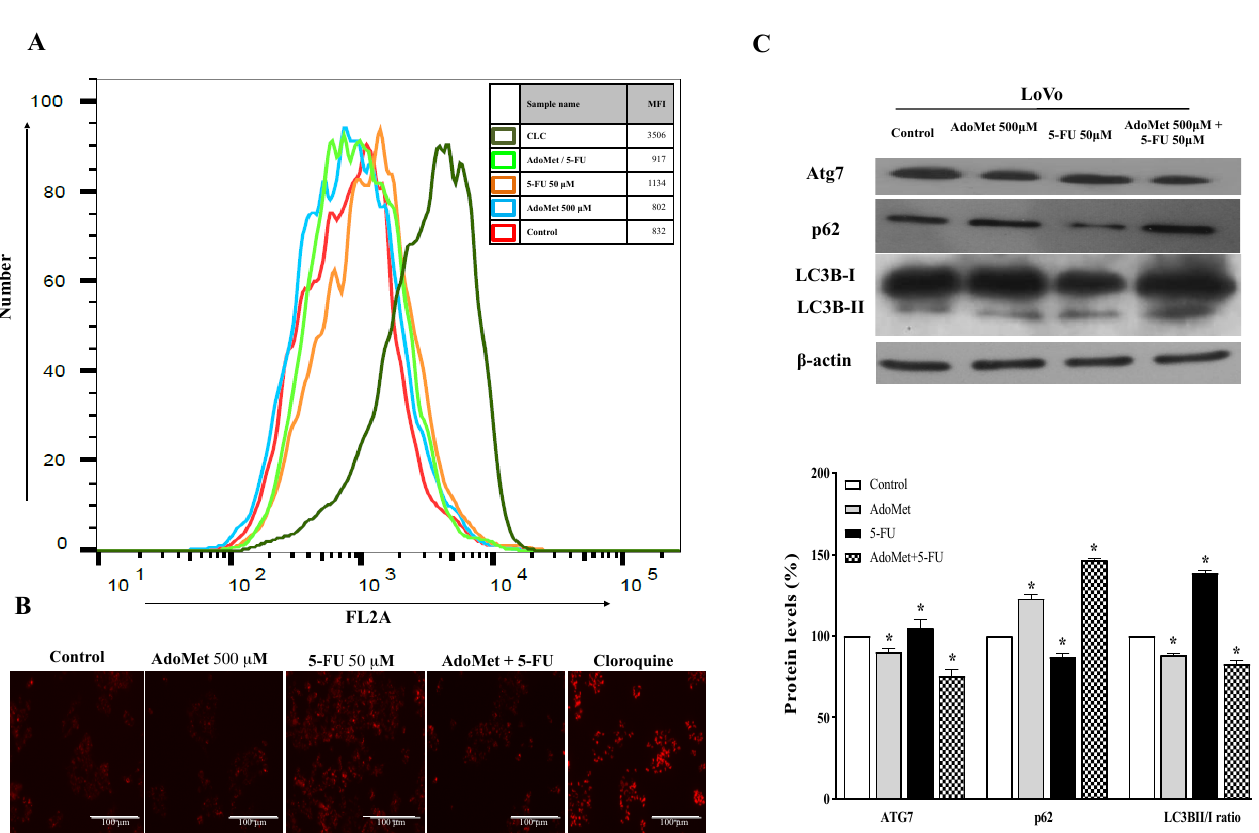
Figure 5. Effects of AdoMet, 5-FU, and their combination on the autophagic process in LoVo cells. Cells were treated with 5-FU 50 µ M for 24 h with and without pretreatment with 500 µ M AdoMet for 24 h. Cells were then incubated with LTR and analyzed by flow cytometry ( A ) and fluorescence microscopy ( B ). Chloroquine was used as a positive control. For the quantitative evaluation of autophagy, the FlowJo software was used to calculate median fluorescence intensities (MFI) by the formula (MFI-treated/MFI-control). At least 2 × 10 4 events were acquired in log mode. Analysis was carried out by triplicate determination on at least three separate experiments. ( C ) The protein contents of Atg7, p62, and LC3B-II/I were detected by Western blot analysis using the total cell lysates. The β -actin was used as loading control. The graph shows the relative densitometric analyses expressed as percentage of untreated control (100%). Error bars represent the standard deviation, * p < 0.05 versus untreated cells. The images are representative of three immunoblotting analyses obtained from three independent experiments. Full-length blots are shown in Figure